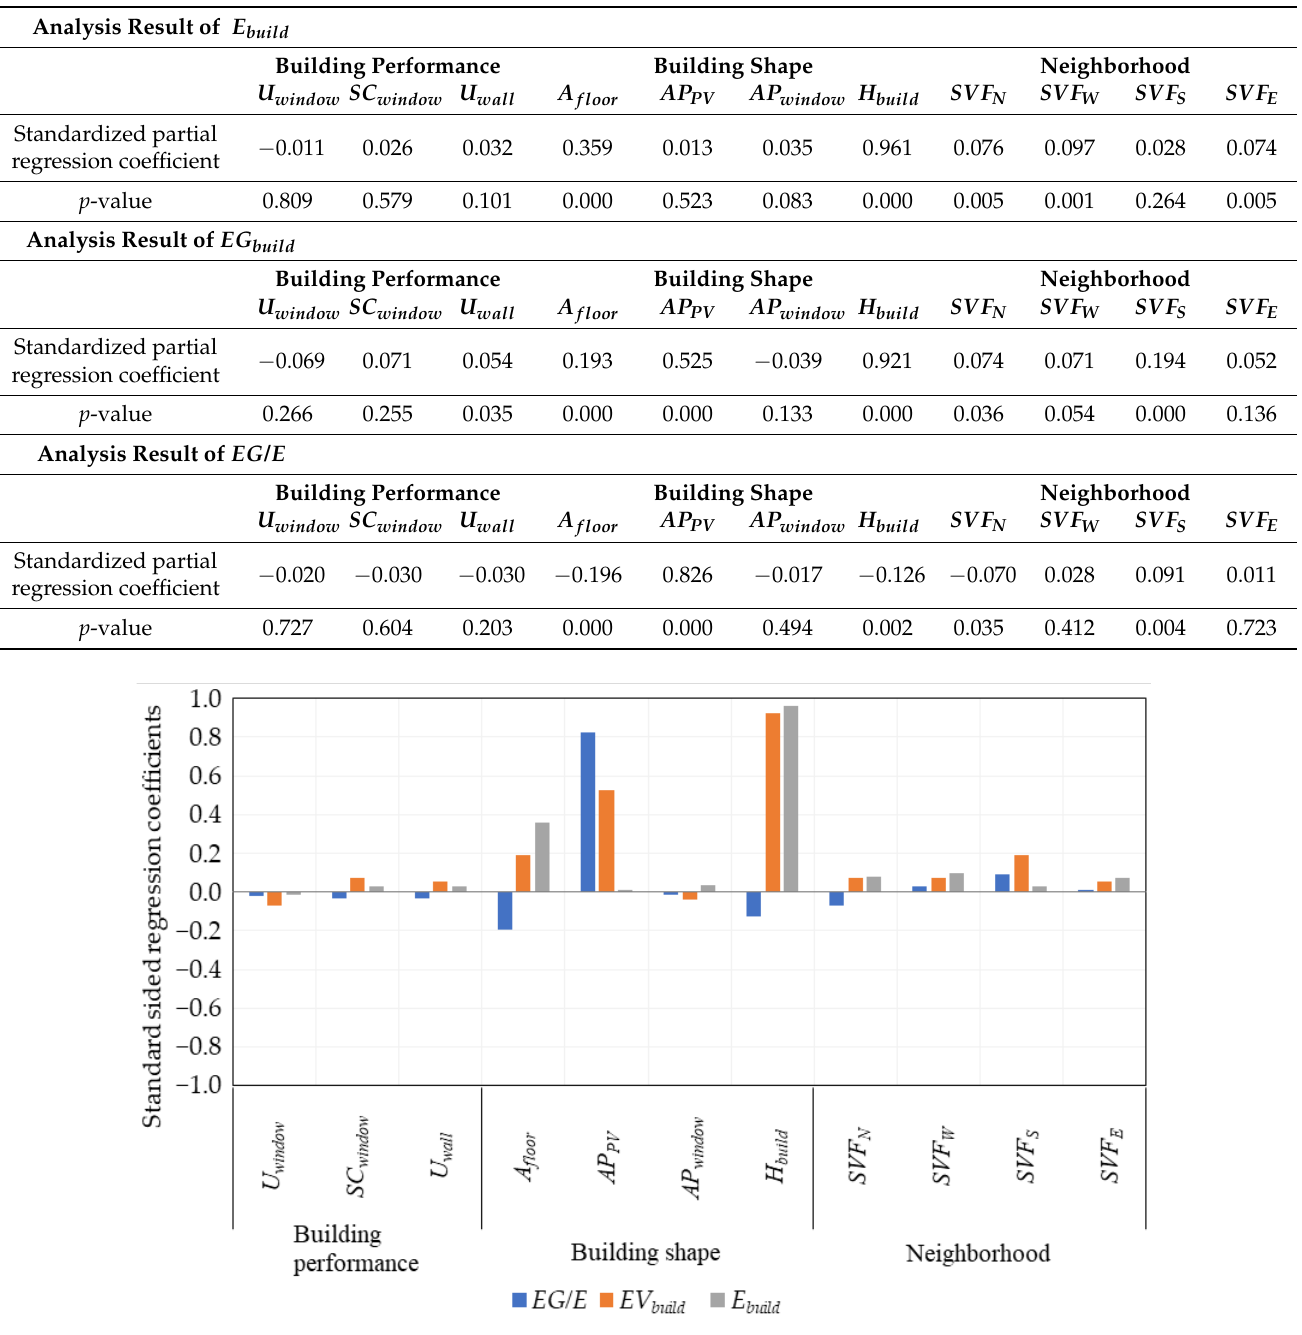
Table 8. Results of multiple regression analysis.